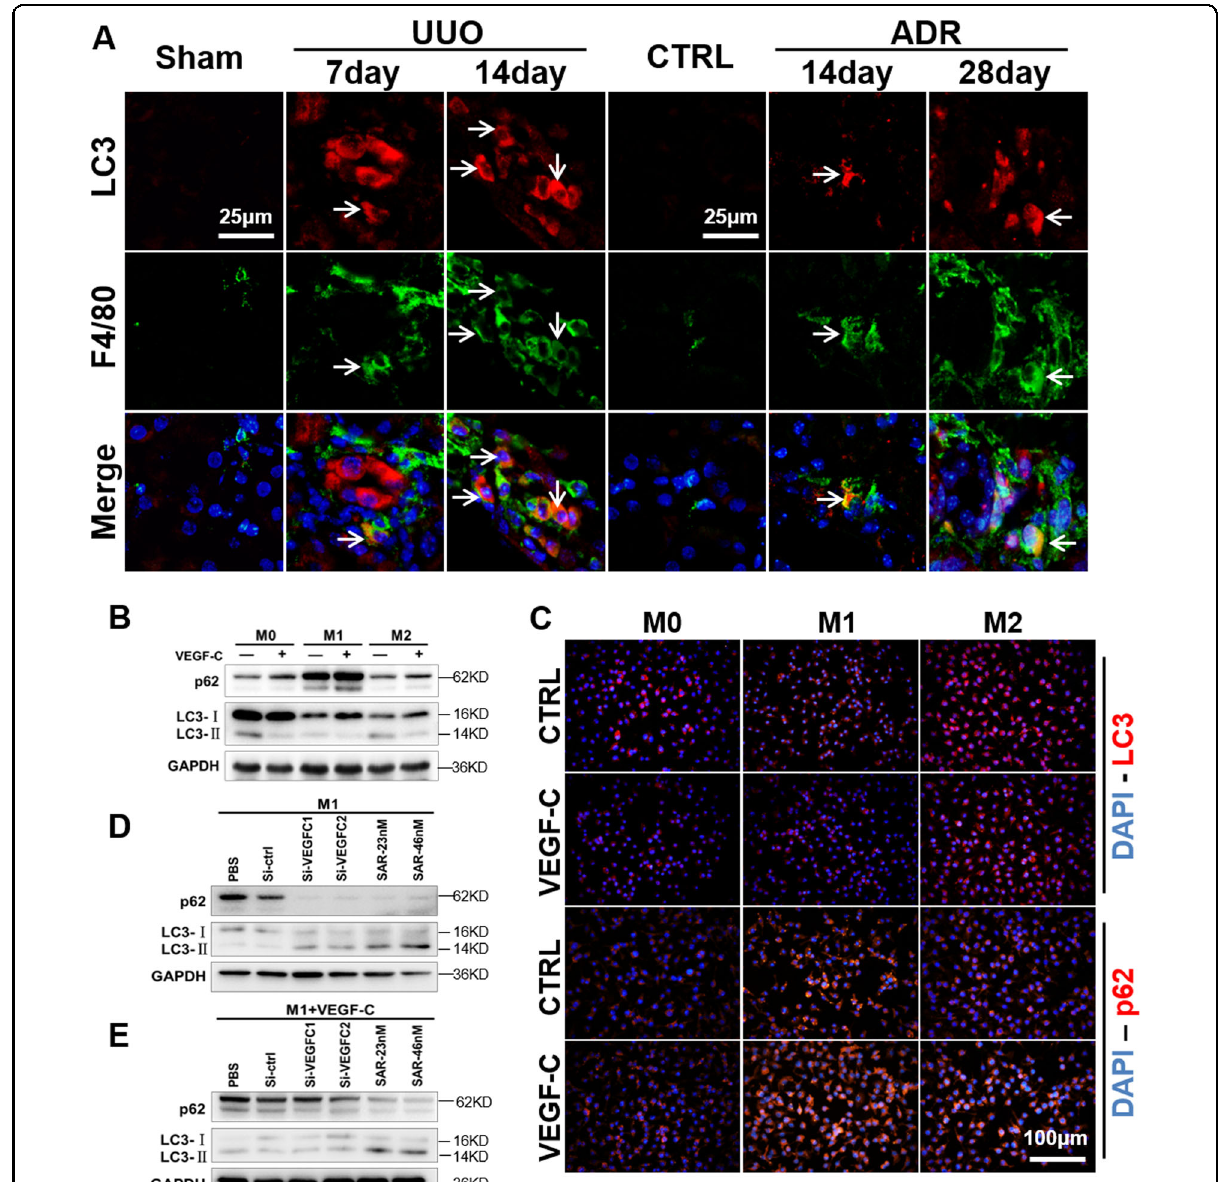
Fig. 7 Autophagy is involved in M1 transdifferentiation into LECs. A In fi ltrated macrophages (F4/80) in UUO and ADR mice exhibited different autophagy levels (LC3) (400×). B Primary BMDMs (M0, M1, and M2) were treated with or without VEGF-C, and the protein expression of autophagy- related markers (LC3 and p62) was measured by western blotting. C Immuno fl uorescence was used to show the effect of VEGF-C on autophagy in BMDM subtypes (400×). D , E M1 cells were treated with VEGF-C, siRNA targeting VEGF-C (Si-VEGF-C) and/or the VEGFR3 inhibitor SAR131675 (SAR-23/ 46 nM), and the protein expression of autophagy markers (LC3 and p62) was measured by western blotting. N =